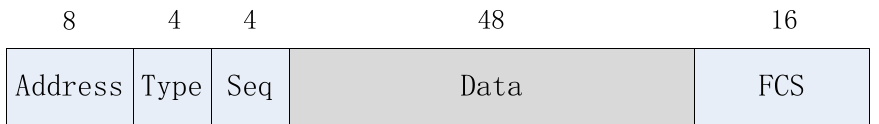
Figure 2. Structure of the interrupt data frame. Seq, sequence; FCS, frame check sequence.